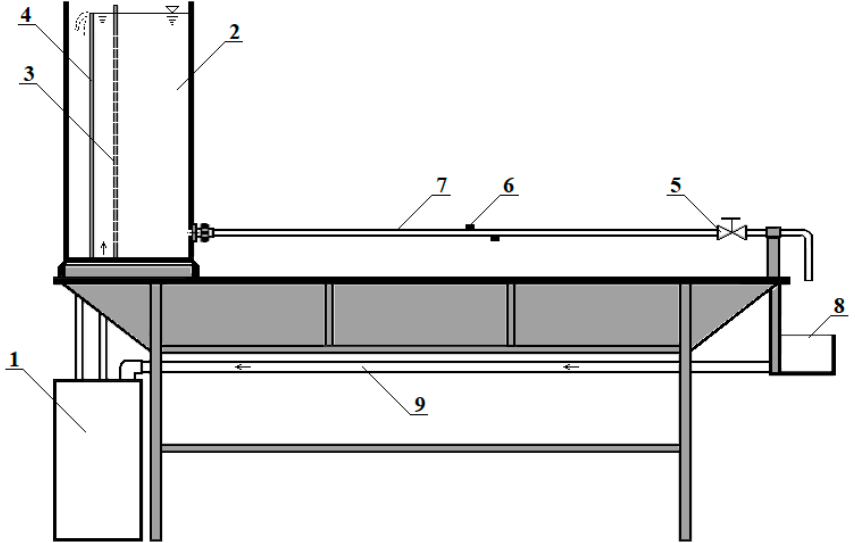
Figure 4. The Reynolds’ apparatus. 1-water tank with pump; 2-tank with constant head; 3-stabilizing plate; 4-overflow plate; 5-regulating valve; 6-ultrasonic transducers; 7-experimental tube; 8-small container; and 9-return tube.